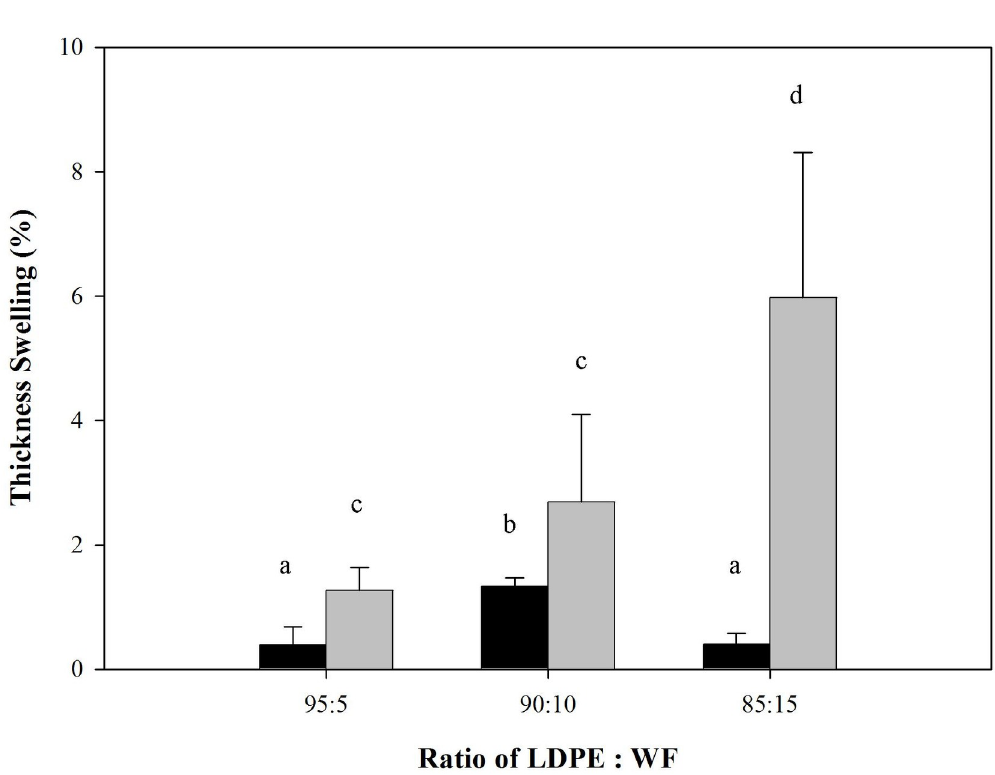
Fig 4. Thickness swelling of predominantly plastic WPCs (Different letter upper the bars are statistically different according to the DMRT at α = 0.05).